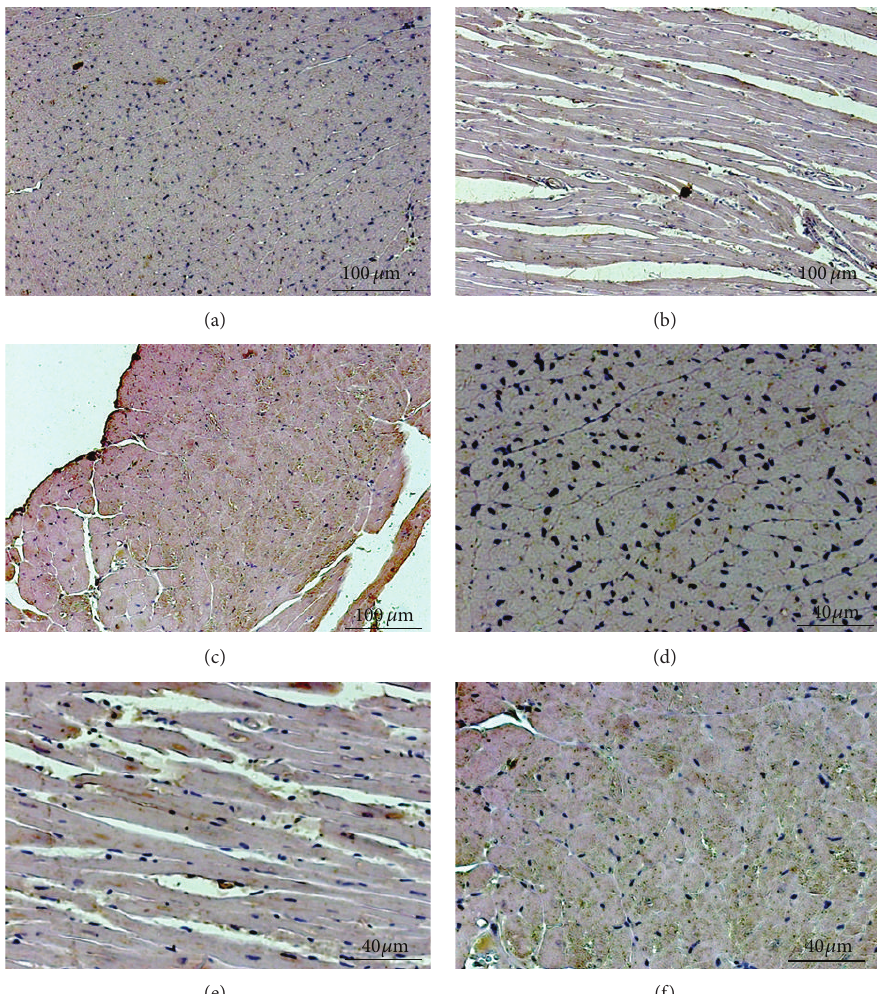
Figure 6: Immunohistochemistry for parasite antigens. Photomicrographs from left ventricular sections stained with T. cruzi antigens by peroxidase reaction. Panels (a) and (d): control nontreated mouse. Panels (b) and (e): chagasic nontreated mouse. Panels (c) and (f): chagasic mouse treated with pyridostigmine bromide. Top panels: magnification = 100x; bottom panels: magnification = 200x. Note the gray color labeling T. cruzi antigens throughout the sections in Panels (b), (c), (e), and